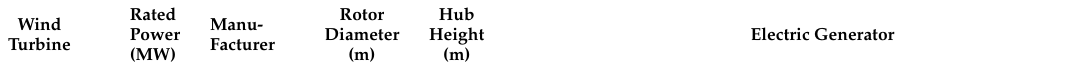
Table 6. List of ultra-large operational direct drive permanent magnet synchronous generators.